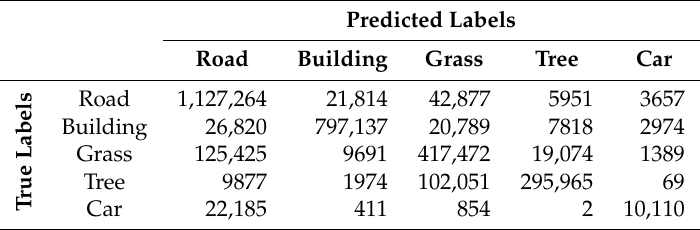
Table 2. Weighted confusion matrix.